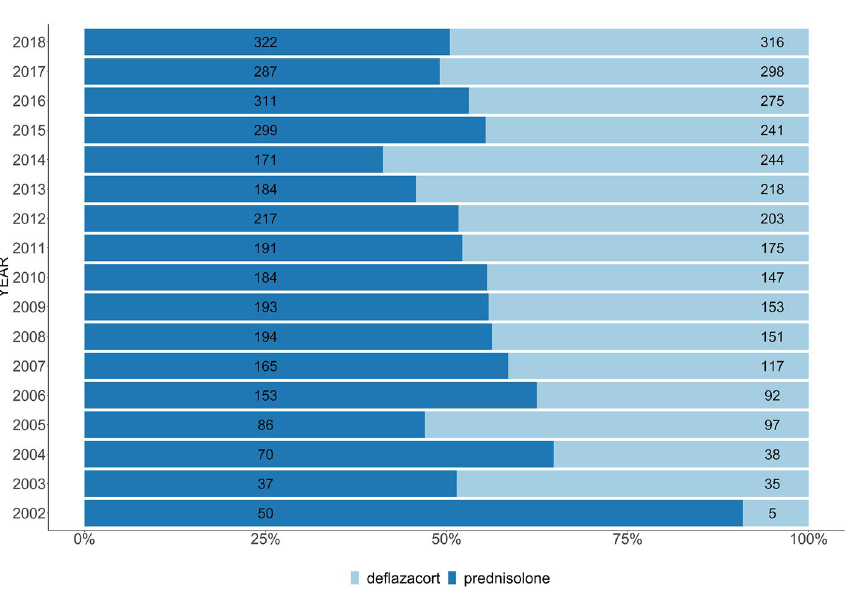
Figure 3. Proportion of deflazacort and prednisolone prescription in